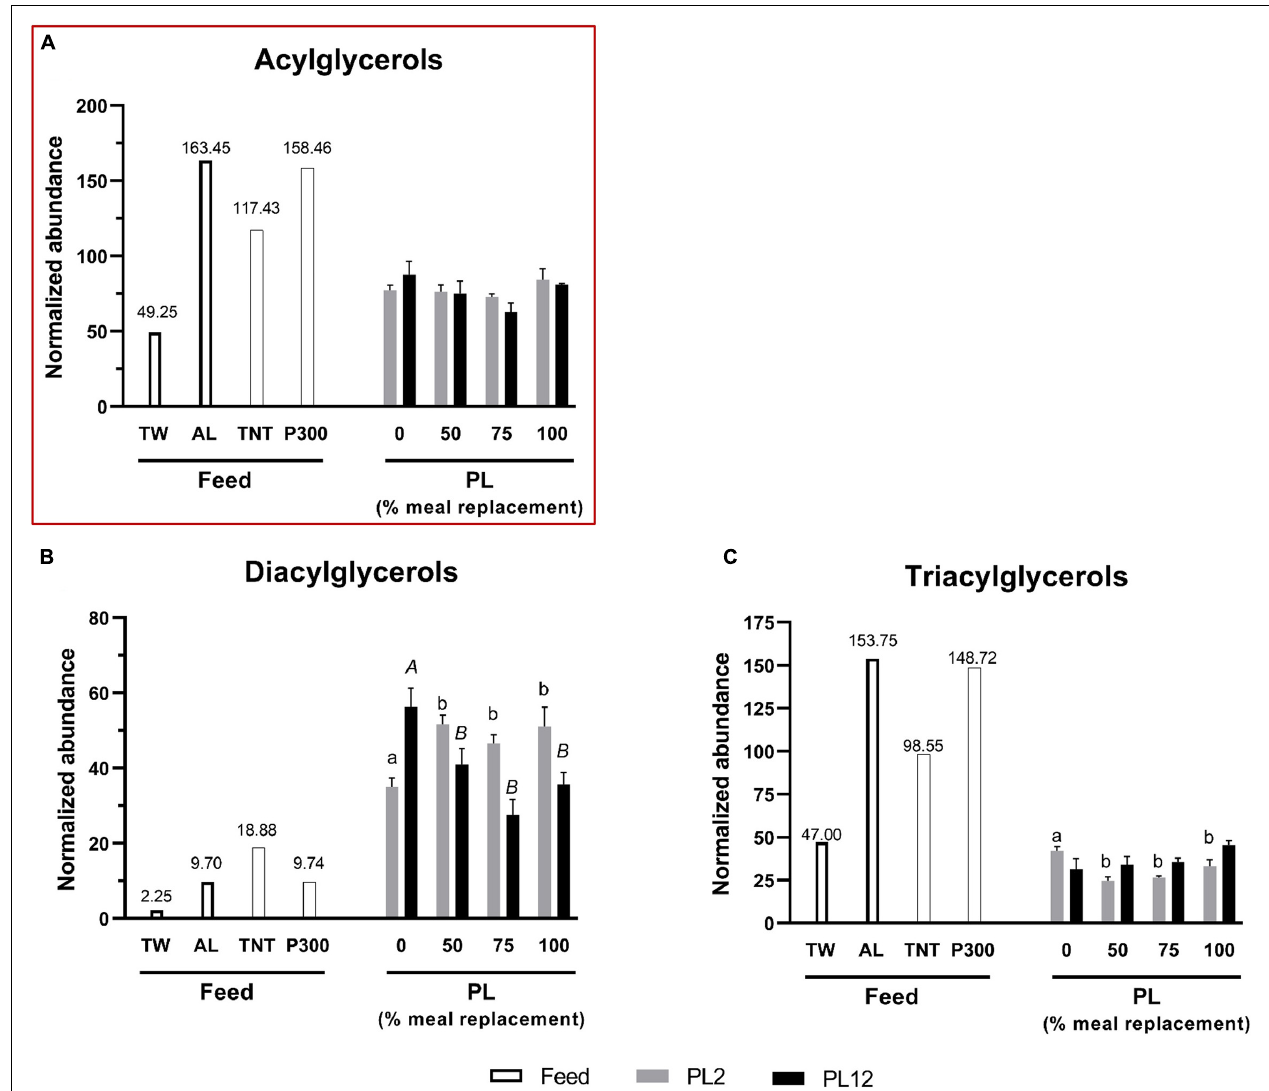
FIGURE 1 | Analysis of acylglycerols in feed and PL shrimp by LC-HRMS. Percent of meal replacement was percent of the number of meals for which TW was replaced by AL. Normalized abundance was derived from the peak intensity value normalized to that of tributyrin, the internal standard. Error bars represent standard errors ( N = 3). Statistical analyses of the PL2 and PL12 data sets were performed separately, using ANOVA. Significant differences among subsets of treatment groups were determined by Duncan’s multiple range test ( P < 0.05); subsets with means not significantly different from one another are identified with the same letter above the bar. Small- and big-capital letters are individually for the PL2 and PL12 data sets, respectively. Bars with no specified letters mean no significant differences were identified among the groups ( P >